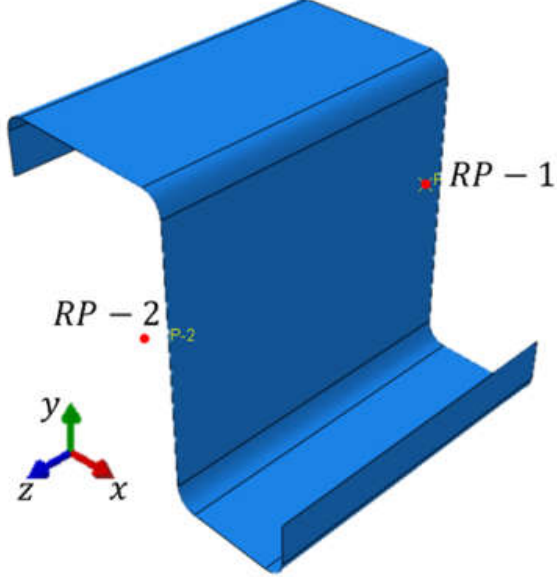
Figure 3. RVE model of the Z profile with the reference points marked in red.